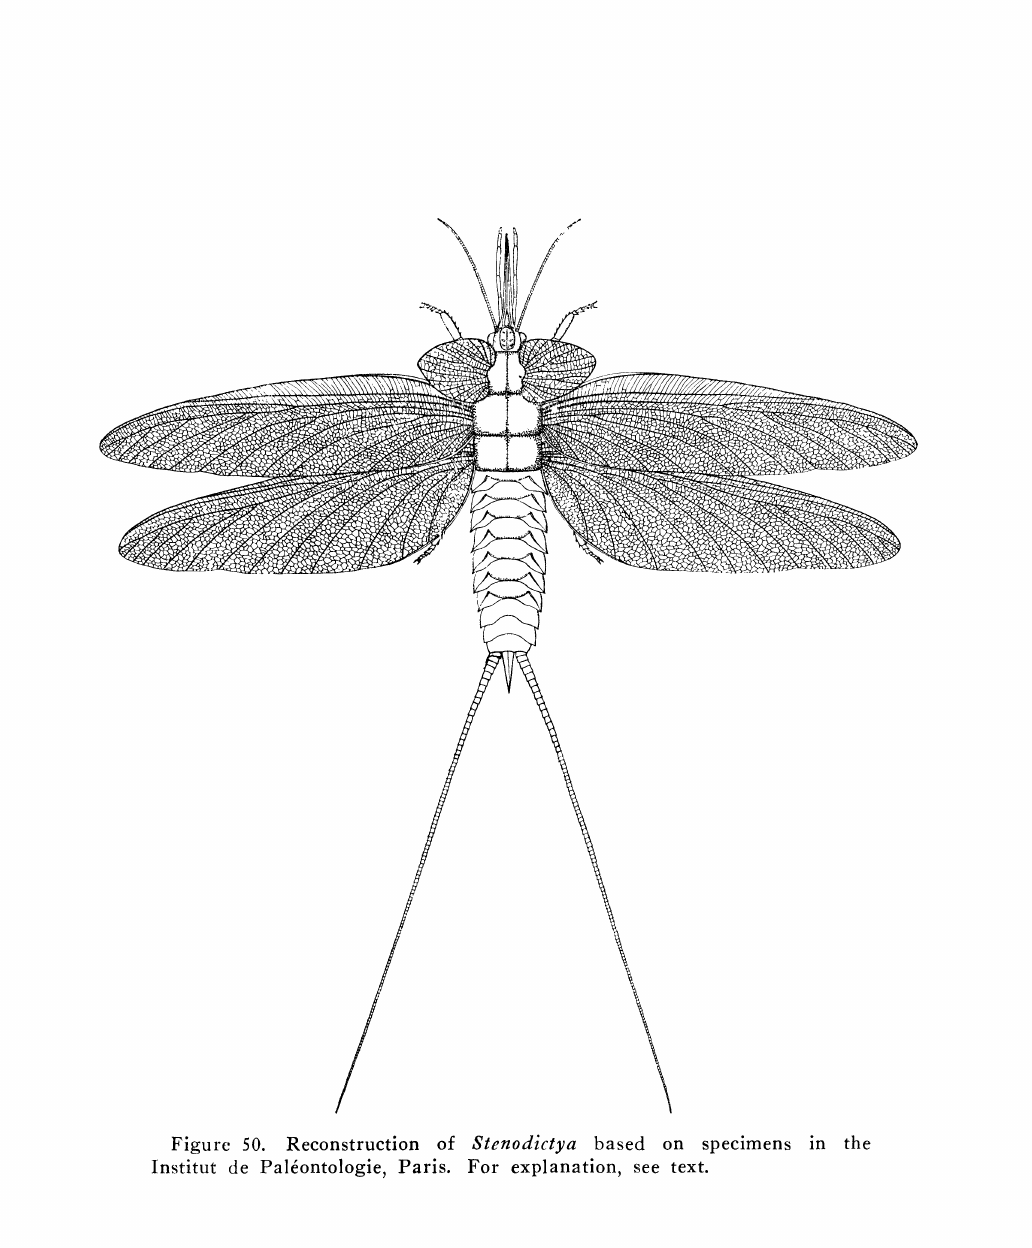
Figure 50. Reconstruction of Stenodictya based on specimens in the Institut de Pal6ontologie, Paris. For explanation, see